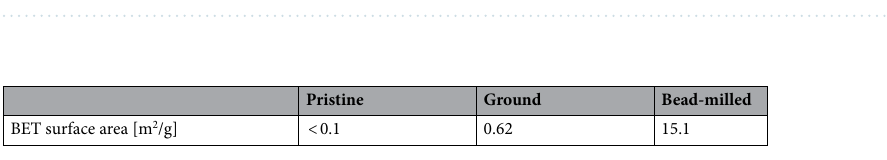
Figure 4. Gas adsorption measurement of bead-milled FA. ( a ) Adsorption isotherm. ( b ) BET plot.